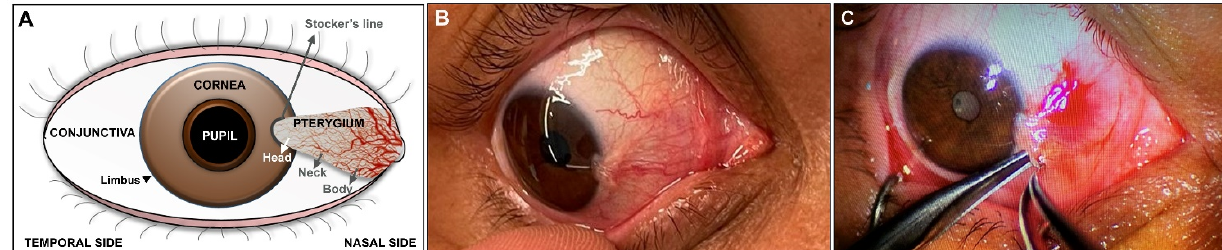
Figure 1. Surgical procedures. ( A ) Scheme of the pathology of a unipolar pterygium developing on the nasal side of the conjunctiva. Different areas in the anatomy of the eye and pterygium have been identified; ( B ) preoperative appearance in a grade II pterygium patient that exceeds the limbus and approaches the pupillary area; ( C ) beginning of the surgical process of pterygium excision in the cornea.